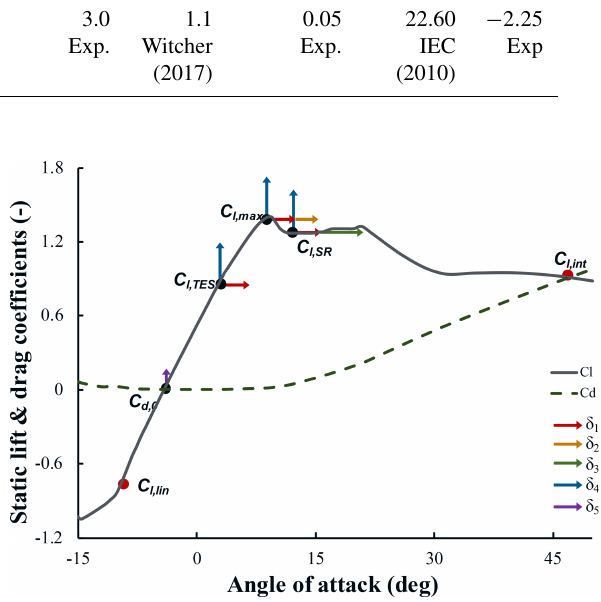
Figure 9. Perturbation of points of interest in representative C l and C d